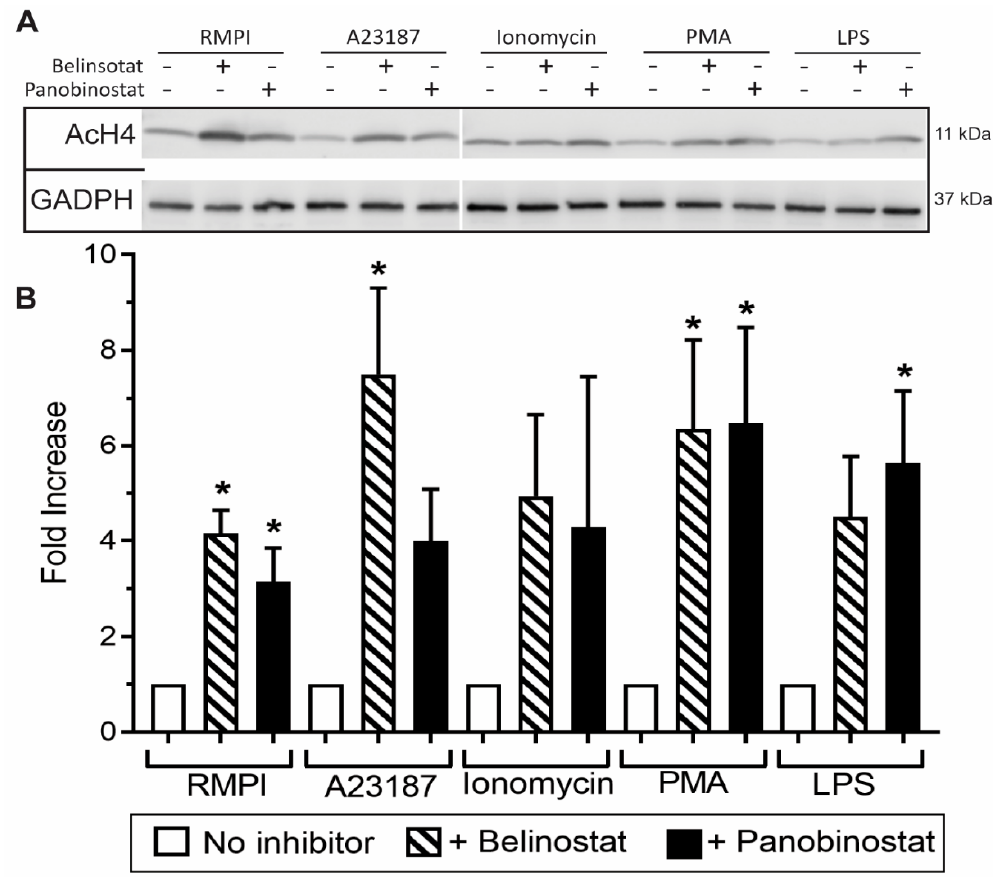
Figure 2. Western blots showing that HDAC inhibitors induce histone acetylation. ( A ) Neutrophils were treated with RPMI (negative control), NETotic agonists (25 nM PMA; 4 µ M A23187; 5 µ g/mL LPS from E. coli 0128; 5 µ M Ionomycin) or HDAC inhibitors (250 nM belinostat; 20 nM panobinostat) for 90 min. For each condition, lysates with the same amount of proteins were separated by polyacrylamide gels, proteins were transferred onto a membrane, and specific proteins were immunodetected (GADPH for loading control and H4K5ac for histone acetylation). ( B ) The densitometry analyses show increased histone acetylation when neutrophils are treated with HDAC inhibitors, compared to their corresponding controls. The values were normalized to the respective control values in each experiment. All data are presented as mean ± standard error of the mean (SEM); n = 3; *, p < 0.05 compared to respective controls. See Supplementary Figure S4 for the full Western blot.